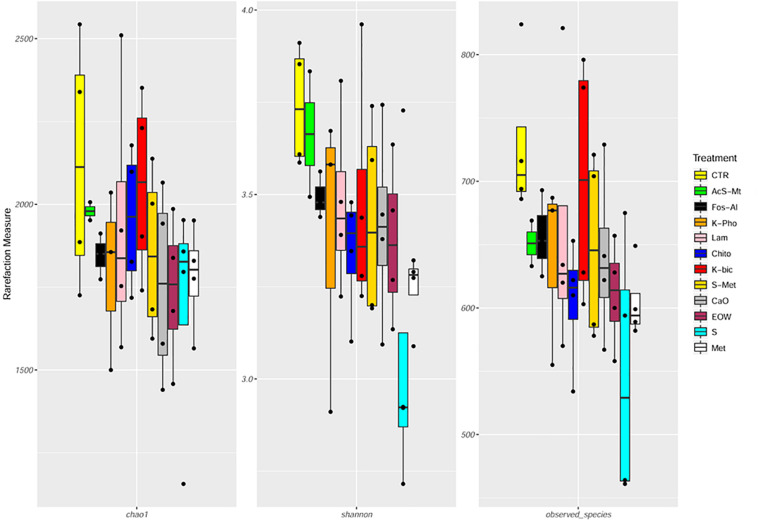
Boxplots to describe α-diversity measures of grape mycobiota. Individual points and brackets represent the richness estimate and the theoretical standard error range, respectively. Treatment descriptions are reported in Table 1.